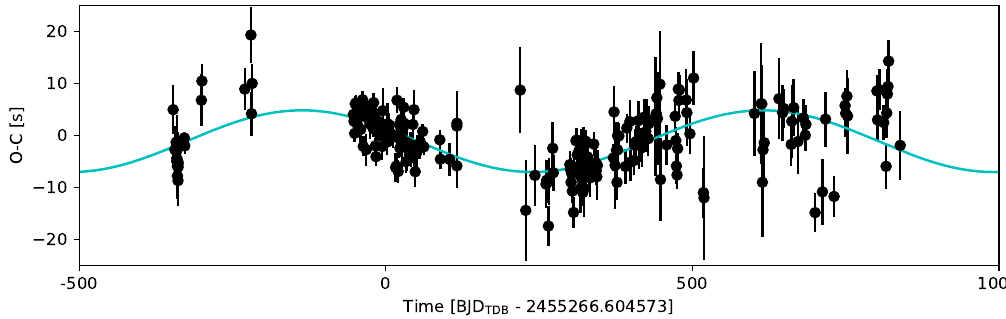
Figure 3. O-C diagram with parabolic and short-period sinusoidal trends pre-whitened. The biennial oscillation occurs with a period of 2.09 ± 0.05 yr, consistent with reflex motion of the entire sdB+dM binary.